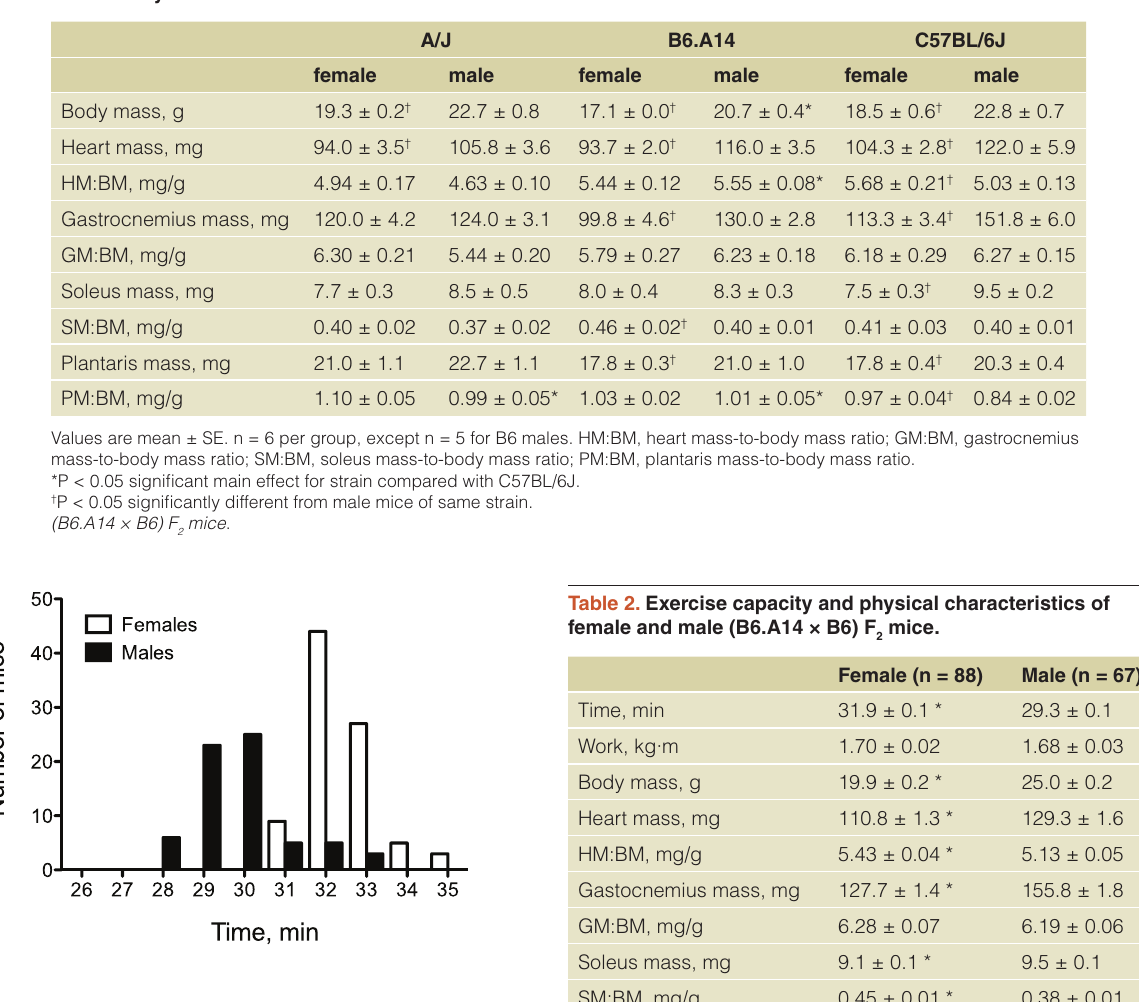
Table 1. Physical characteristics of female and male inbred and B6.A14 CSS mice.